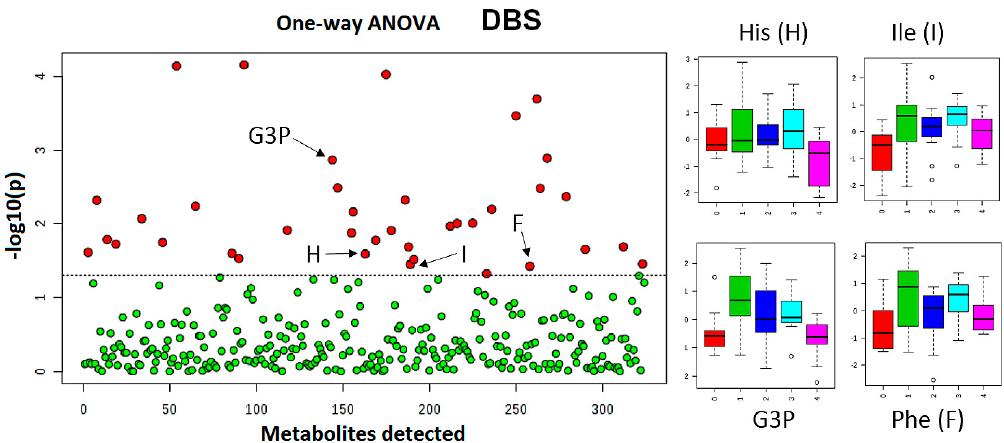
Figure 5. Intra-day variation of blood metabolome. One-way ANOVA analysis results (subject = 12, days = 1, p value threshold 0.05) for DBS samples. Left panel: X axis presents total number of metabolites detected. Red circles illustrate metabolites which levels showed statistically significant differences. Right panel: Box plots depict selected metabolites temporal changes at time points 0–4 (corresponding to fasting 7 AM, 10 AM, 1 PM, 4 PM, and 7 PM). Y axis shows the normalized relative abundance.